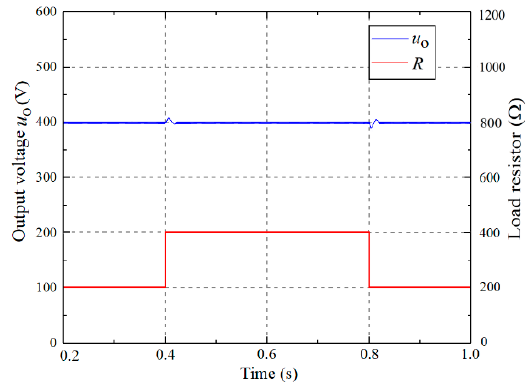
Figure 6. The output voltage variations under input voltage disturbance. ( a ) With only feedback controller; ( b ) with feedback controller and feedforward compensation.